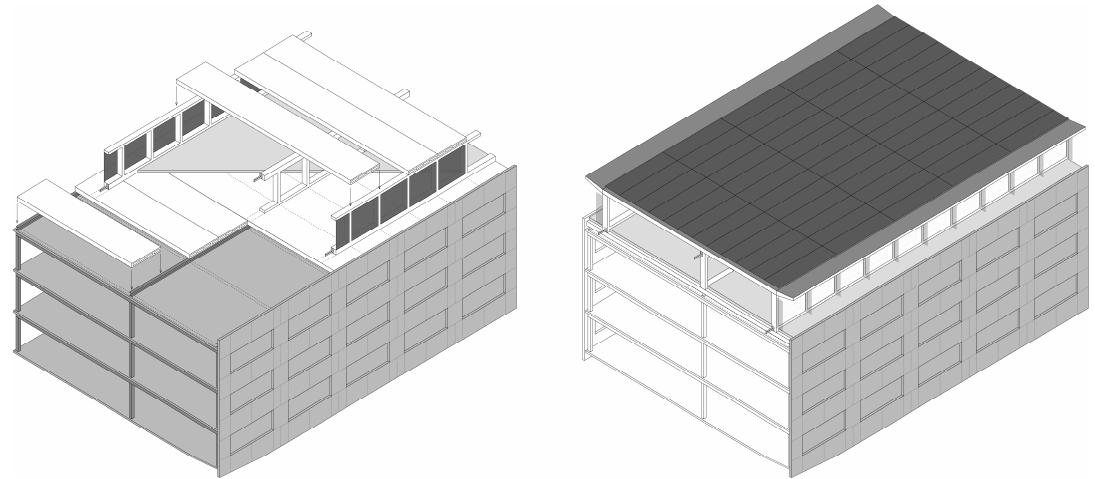
Figure 2. Axonometric views of the Working Space construction system, based on a reference grid.